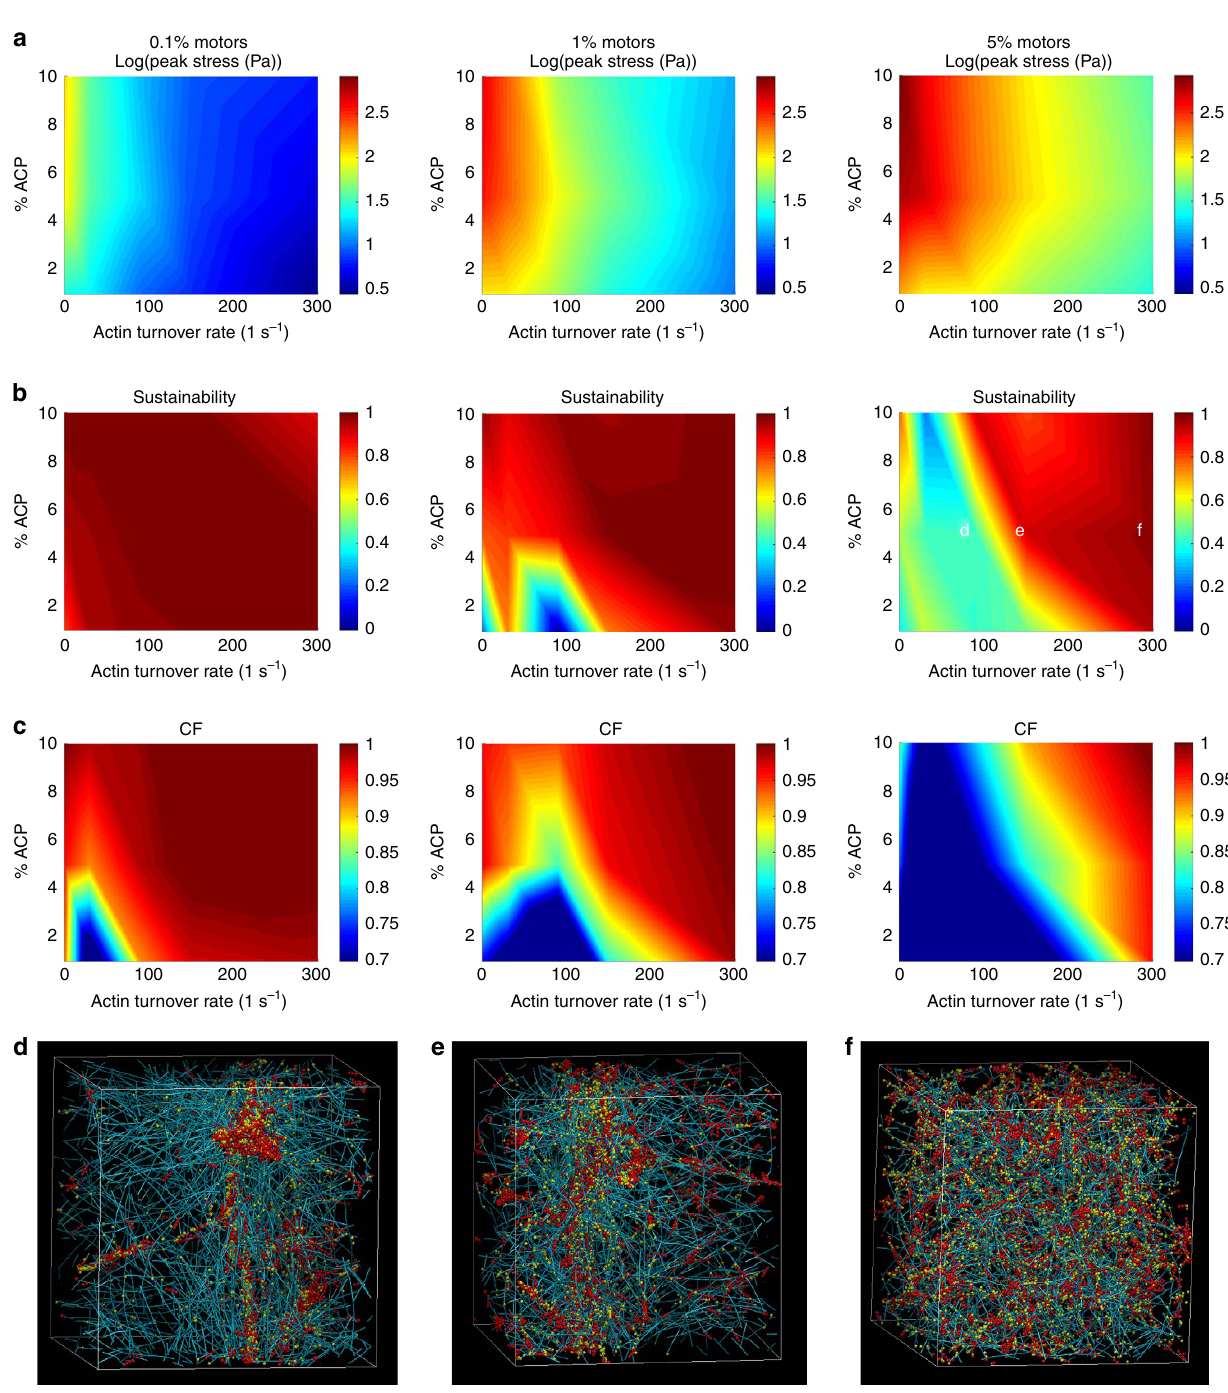
Figure 3 | Mechanical phase transition of 3D cytoskeletal networks. ( a ) The peak stresses, ( b ) stress sustainability factor (see Supplementary Note 2) and ( c ) clustering factor CF (see Supplementary Note 3) at t ¼ 40s after motor activation are plotted as a function of the actin turnover rate and % ACP. (See Supplementary Fig. 8 for CF heat maps at the end of simulation time). Each column represents a different motor concentration in the network. The actin concentration in these simulations is 25 m M. The peak stress (maximum stress exhibited by the network over time once the motors are activated averaged over a 10-s time interval) is reduced with increasing actin turnover rate and is enhanced with increasing motor concentration. The sustainability of the generated stresses and homogeneous network morphology tend to scale proportionately with ACP concentration and actin turnover rate and inversely with motor concentration. ( d – f ) Representative network morphologies of the indicated points in b 51s after motor activation. Teal, yellow and red are actin filaments, ACPs and motors,